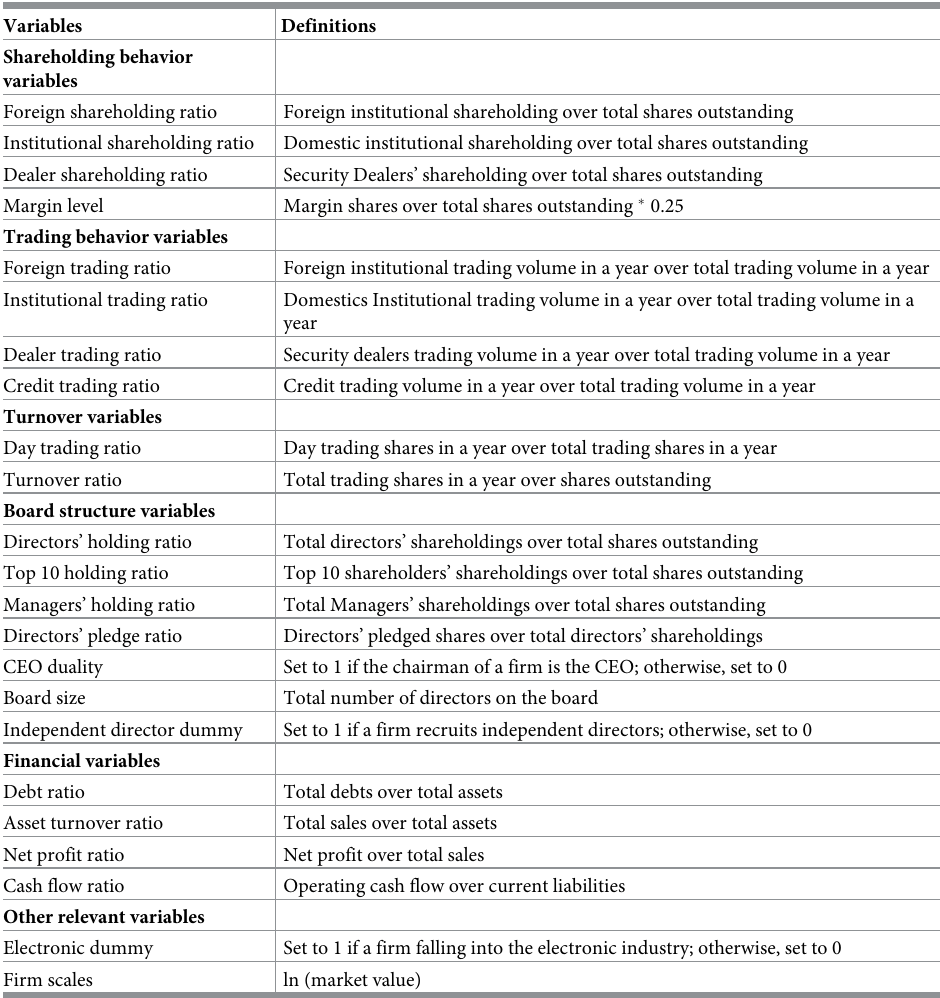
Table 1. Definitions of